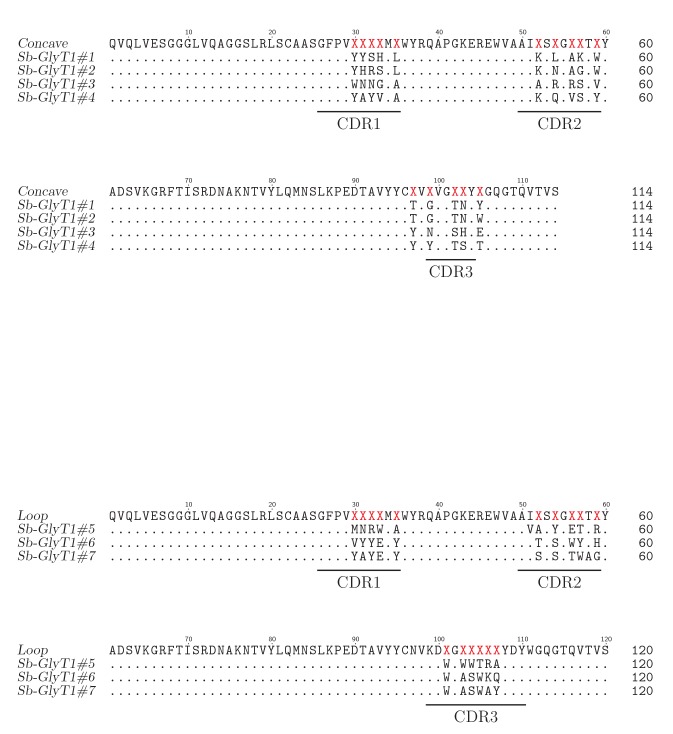
Sequence alignment of sybodies raised against GlyT1.